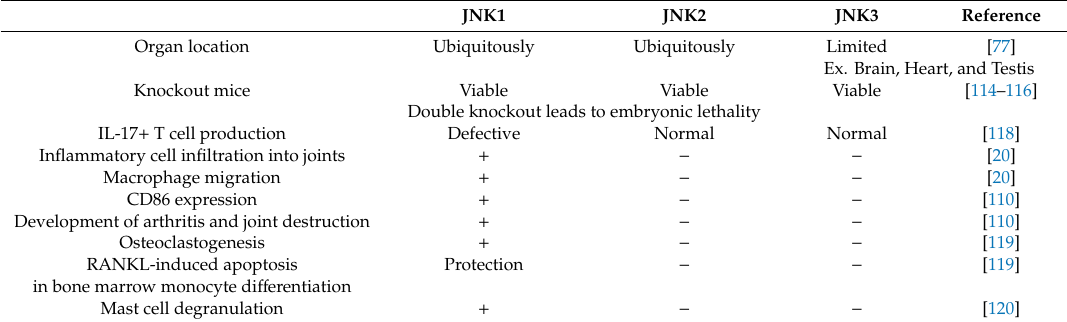
Table 1. Arthritis-associated e ff ects mediated by JNK